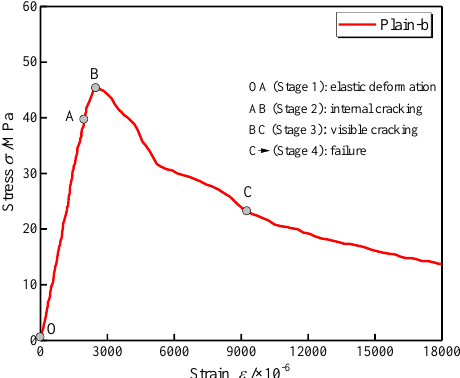
Figure 3. A typical example of the compressive stress – strain